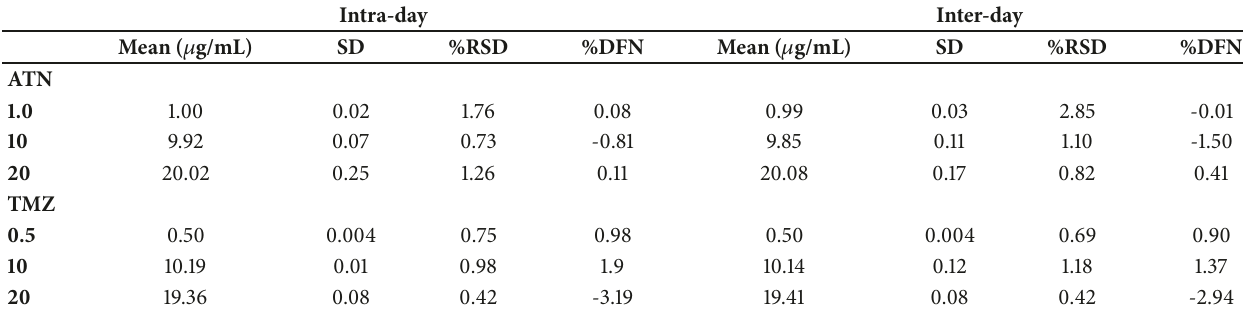
Table 5: Intra- and interday precision and accuracy calculated from quality control (QC) samples in human urine.